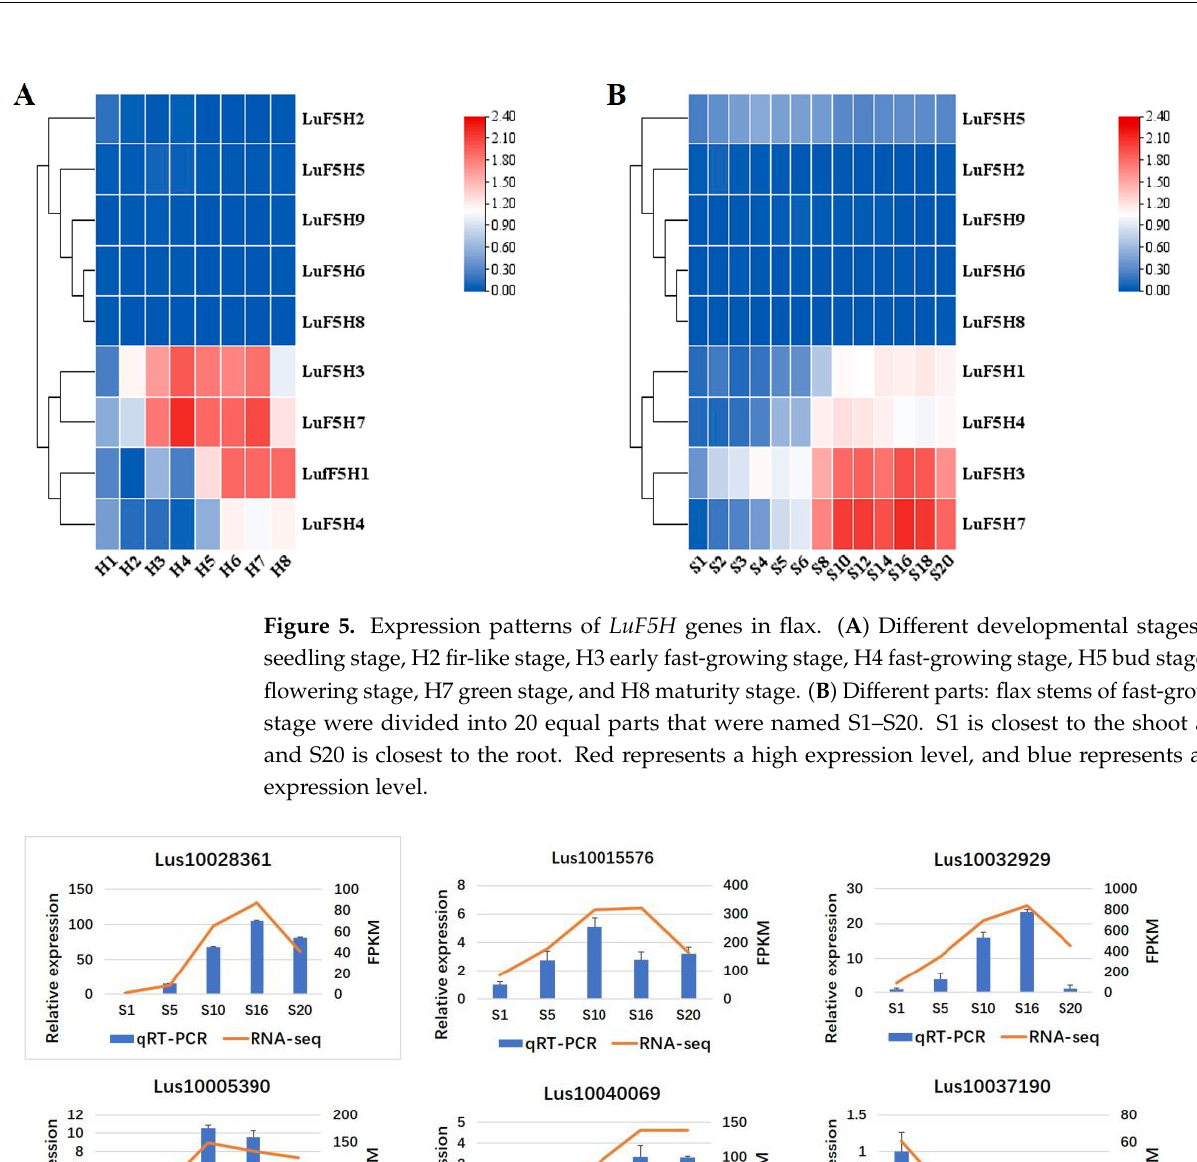
Figure 5. Expression patterns of LuF5H genes in flax. ( A ) Different developmental stages: H1 seed- ling stage, H2 fir-like stage, H3 early fast-growing stage, H4 fast-growing stage, H5 bud stage, H6 flowering stage, H7 green stage, and H8 maturity stage. ( B ) Different parts: flax stems of fast-grow- ing stage were divided into 20 equal parts that were named S1 – S20. S1 is closest to the shoot apex, and S20 is closest to the root. Red represents a high expression level, and blue represents a low expression level.